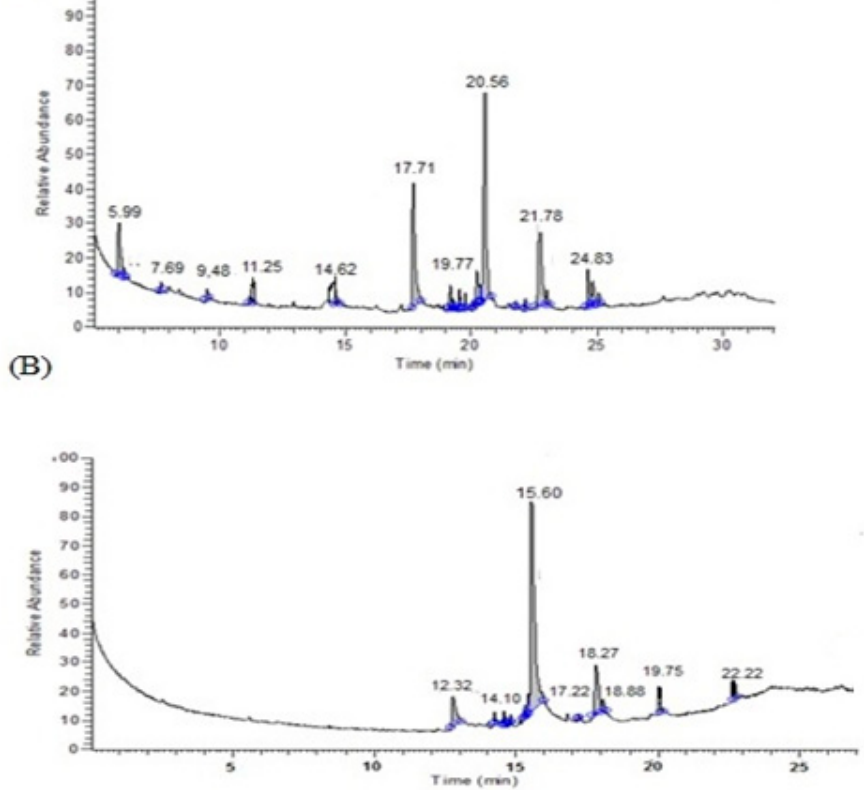
Figure 2. Gas chromatography-mass spectrometry (GC-MS) chromatogram of the methanolic extracts of H. cuneiformis ( A ) and A. fragilis ( B ).